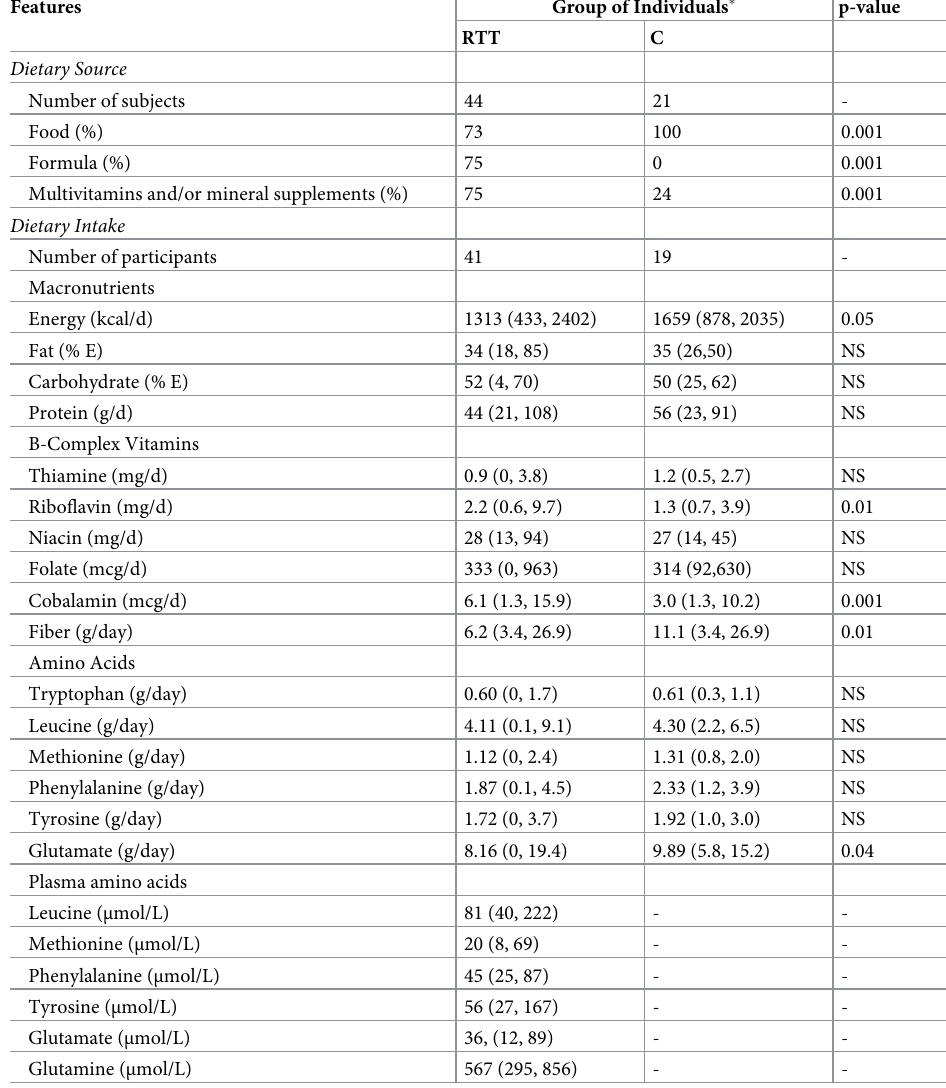
Table 2. Dietary intakes of participants with RTT and unaffected controls.